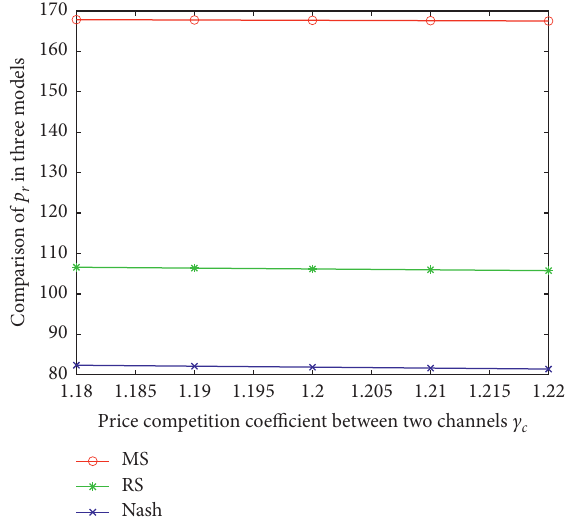
Figure 8: The comparison of the optimal direct sales price of customized products p z in the three models.